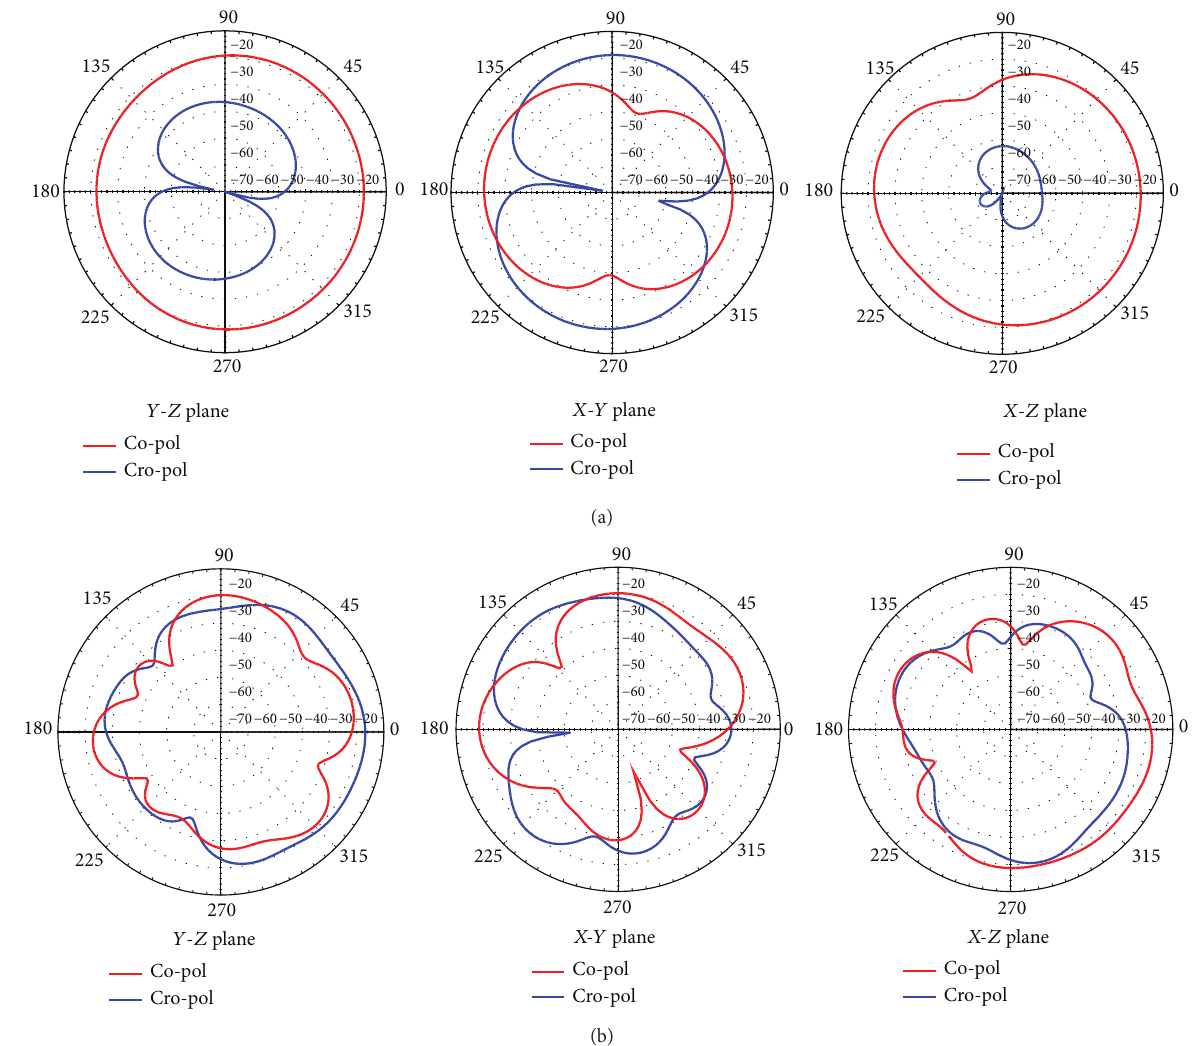
Figure 8: Measured 2D radiation pattern of the proposed antenna: (a) 2.4 GHz; (b) 5.8 GHz.